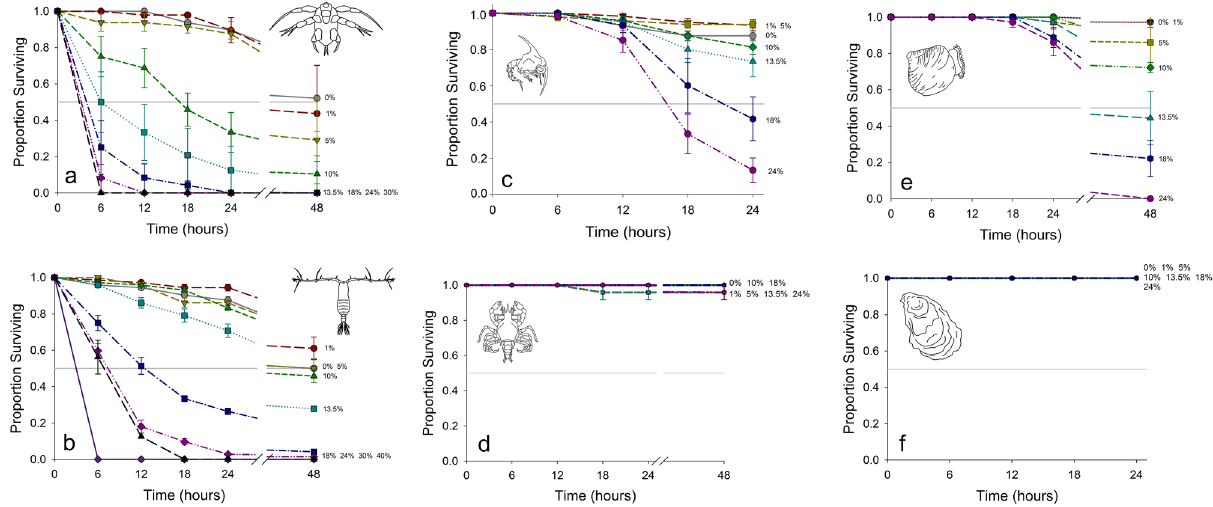
Figure 1. Survival of invertebrate taxa over time in different concentrations of IRI-160AA; the grey horizontal line marks 50% survival. ( a ) A. tonsa nauplii, ( b ) A. tonsa adult females, ( c ) C. sapidus zoeae, ( d ) C. sapidus megalopae, ( e ) C. virginica pediveligers, ( f ) C. virginica adults. See Table 1 for